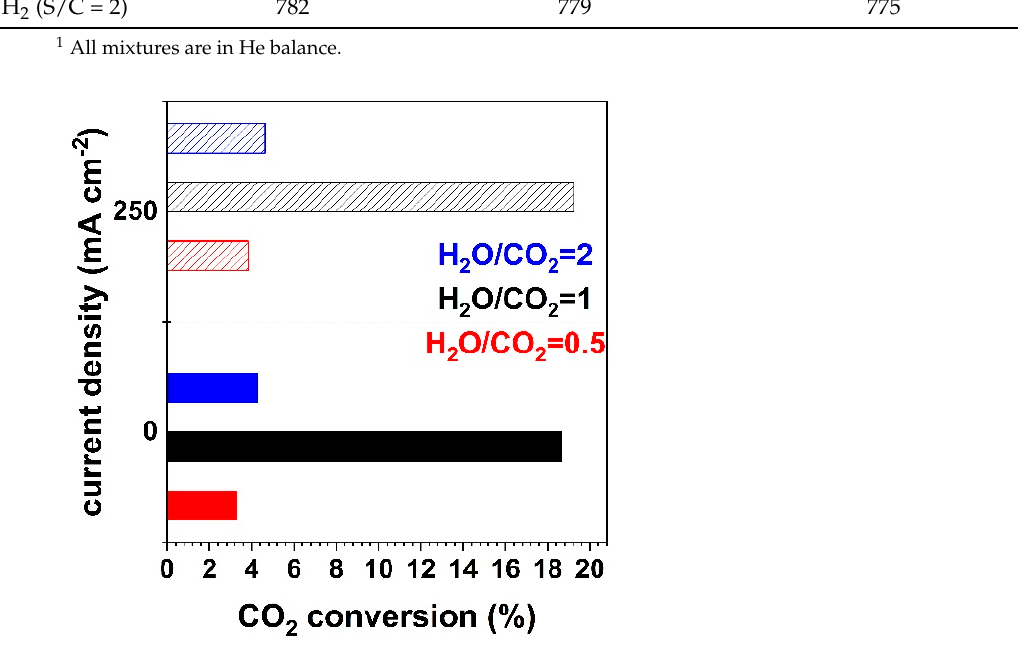
Figure 7. Conversion of CO 2 under a current density of 0 mA cm − 2 (open circuit) and 250 mA cm − 2 for different H 2 O/CO 2 ratios of 0.5, 1 and 2, with H 2 co-feed in the cathode, at 900 °C.